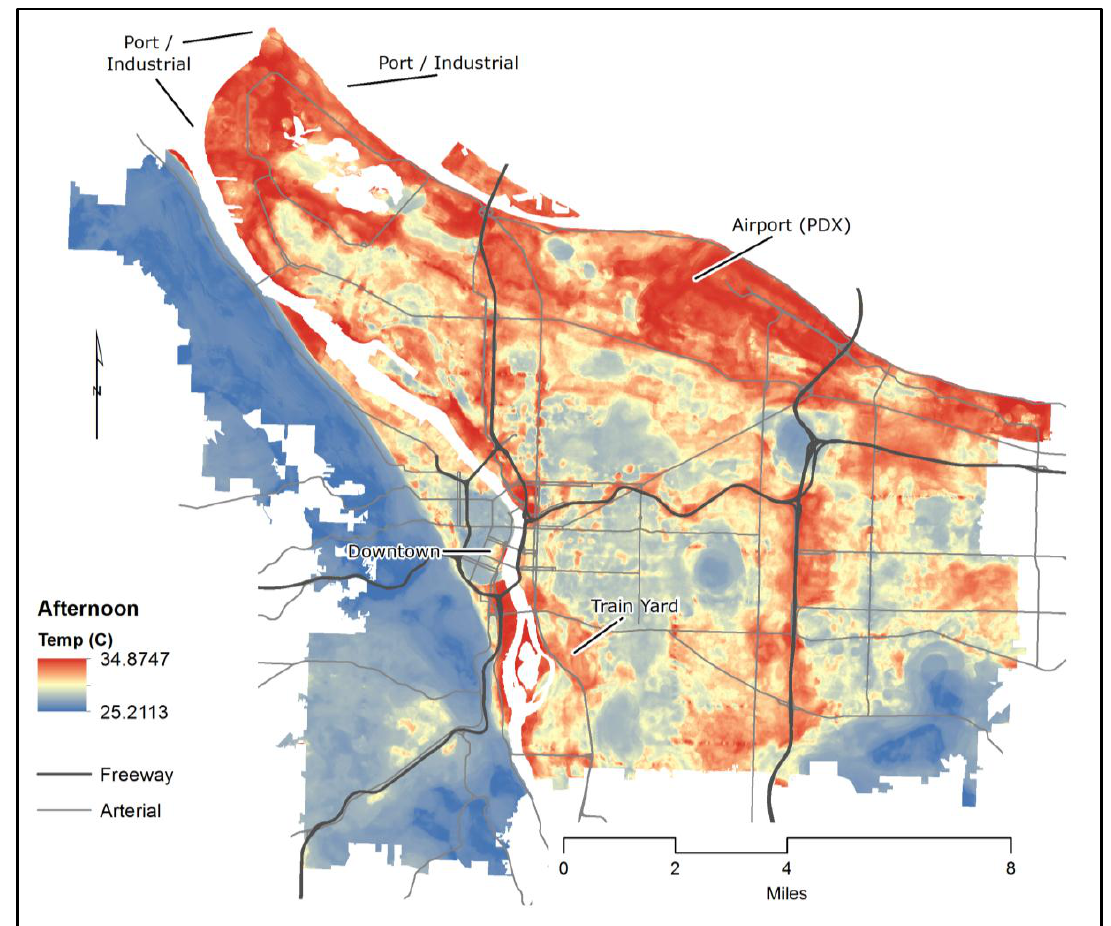
Figure 5. Afternoon UHI modeled raster surface. The river has been masked out visually, however summary statistics incorporate its